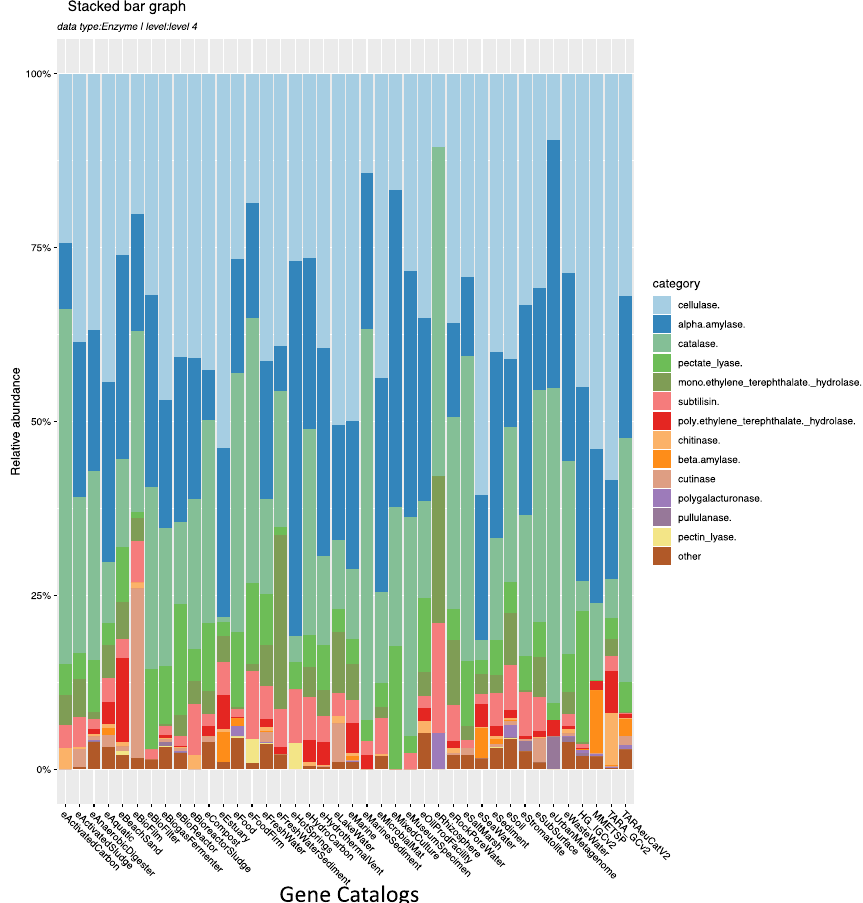
Figure 5. Examples of gene searches in KMAP. Relative abundance of selected extremozymes detected in a variety of microbial habitats. Supplementary Video SV3 shows how to navigate through KMAP to yield these